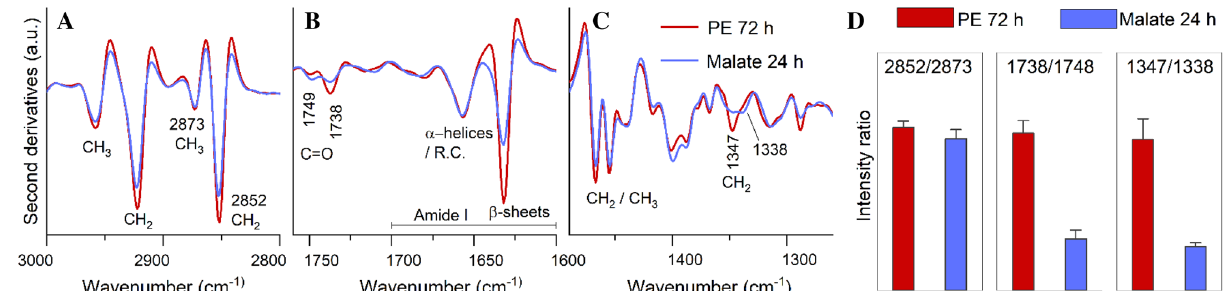
Figure 6. FTIR analysis of R. opacus R7 intact cells. The second derivatives of the mean FTIR absorption spectra of R . opacus R7 cells grown on PE for 72 h and malate for 24 h are reported in the spectral ranges: ( A ) 3000–2800 cm −1 , ( B ) 1760–1600 cm −1 , ( C ) 1500–1250 cm −1 . The peak position and the assignment at selected vibrational modes are indicated. Panel ( D ) shows the intensity ratios between the reported peaks (2852 cm −1 /2873 cm −1 , 1738 cm −1 /1748 cm −1 , 1347 cm −1 /1338 cm −1 ), taken in the second derivative spectra. The error bars represent the standard deviation from three independent